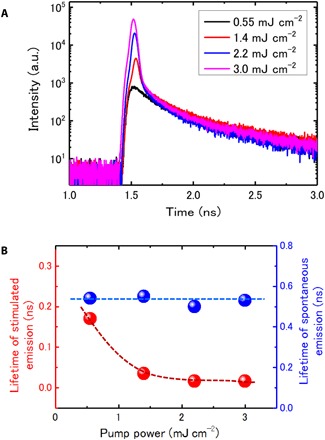
Time-resolved PL measurements using a single-photon detector with a time resolution of ~16 ps under increasing pump power at room temperature.(A) The PL decay curves with increasing pump power. For the power higher than 1.4 mJ cm−2, there are two decay times, namely, spontaneous and stimulated emission. (B) Lifetime of spontaneous and stimulated emission under varied pump power. The lifetime of spontaneous emission remains at the same level of 0.5 to 0.54 ns, while the stimulated emission shows faster lifetime with increasing pump power and eventually approaches a constant level of 0.016 ns, which is the resolution of the detector. The error bar is smaller than the dot size. The dashed lines are guides to the eyes. These features confirm the lasing behavior in the nanowire.